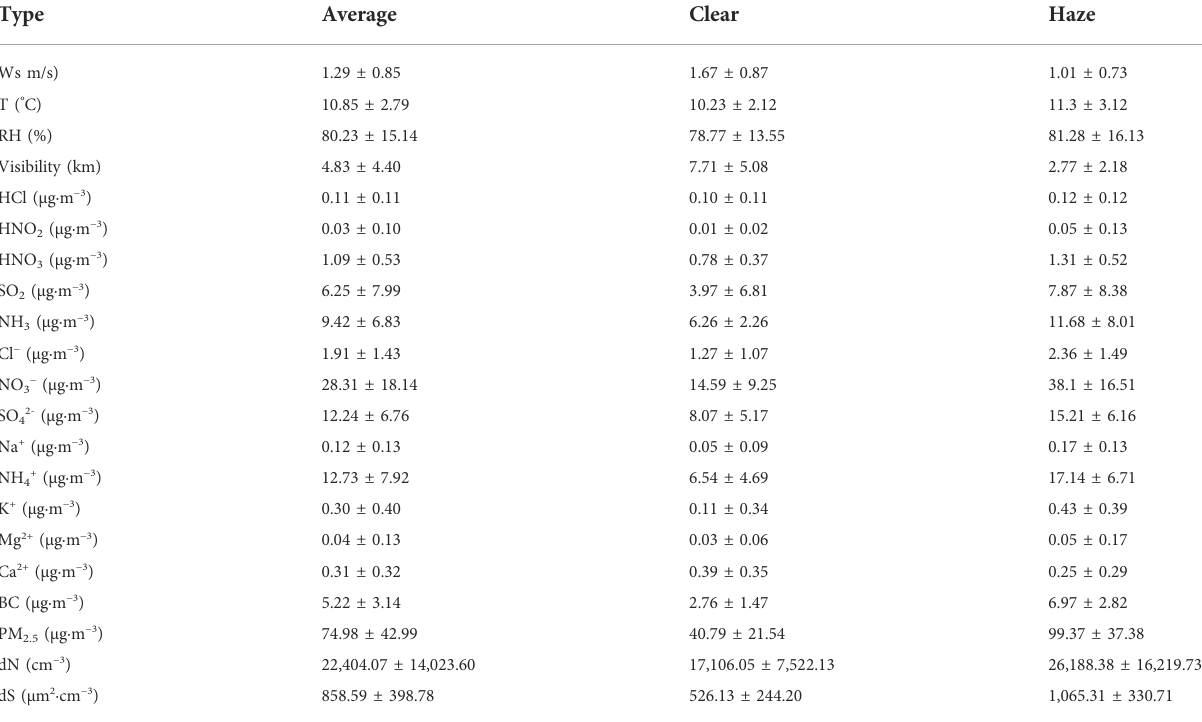
TABLE 1 Summary of average meteorological variables and pollutants during the study period.